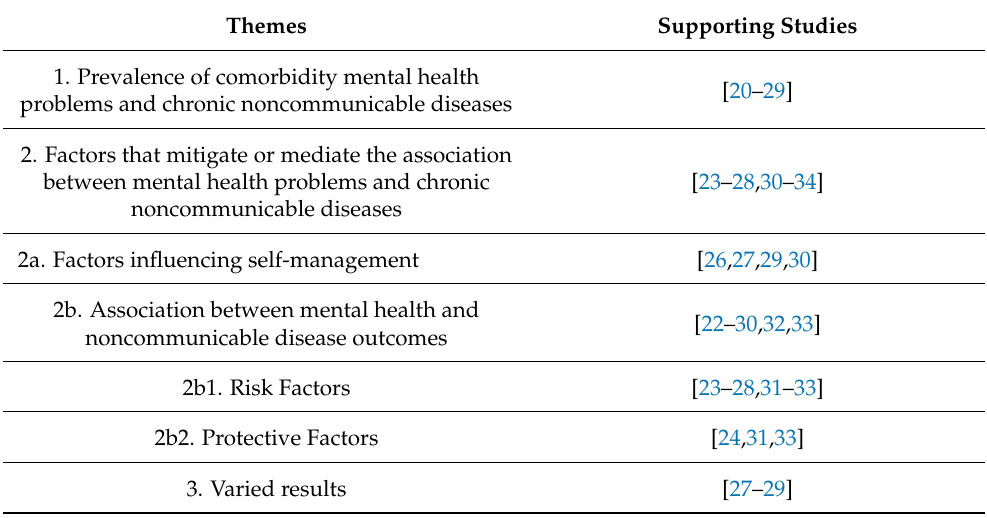
Table 4. Results